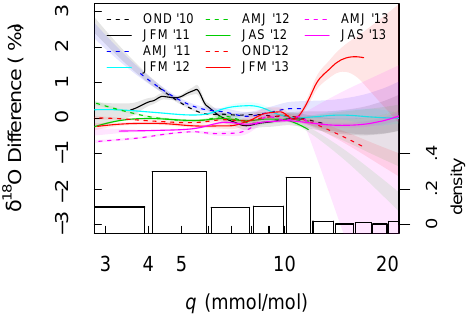
Figure 4. Mauna Loa concentration-dependence characterizations for 3-month periods described in the legend. Only periods where n ≥ 30 are shown. Curves – fit with a local regression – are depicted as a difference from the concentration dependence obtained when using all 3 years of data and are plotted as a function of q – the water vapor volume mixing ratio – on a log scale. Prediction errors are represented by shading. The calibration data density is depicted by bars (rightmost